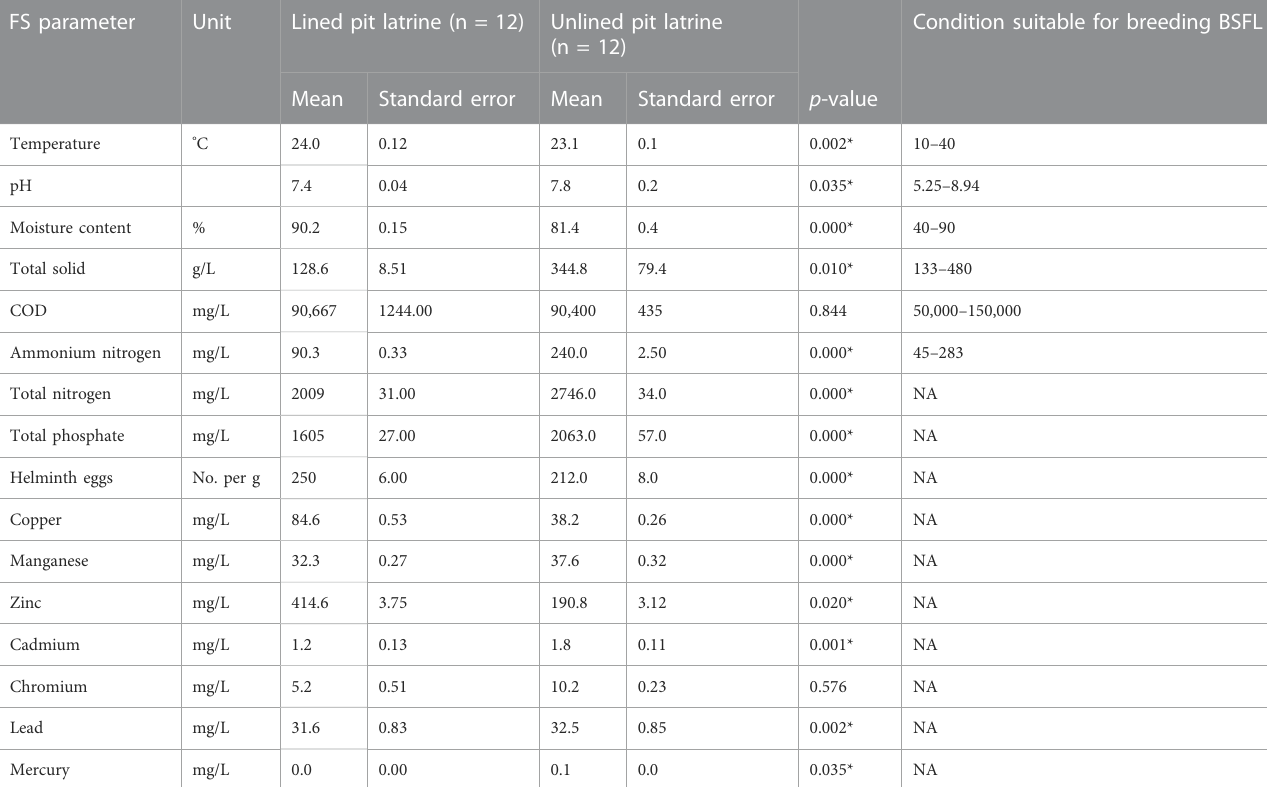
TABLE 2 Characteristics of FS from lined and unlined pit latrines in urban